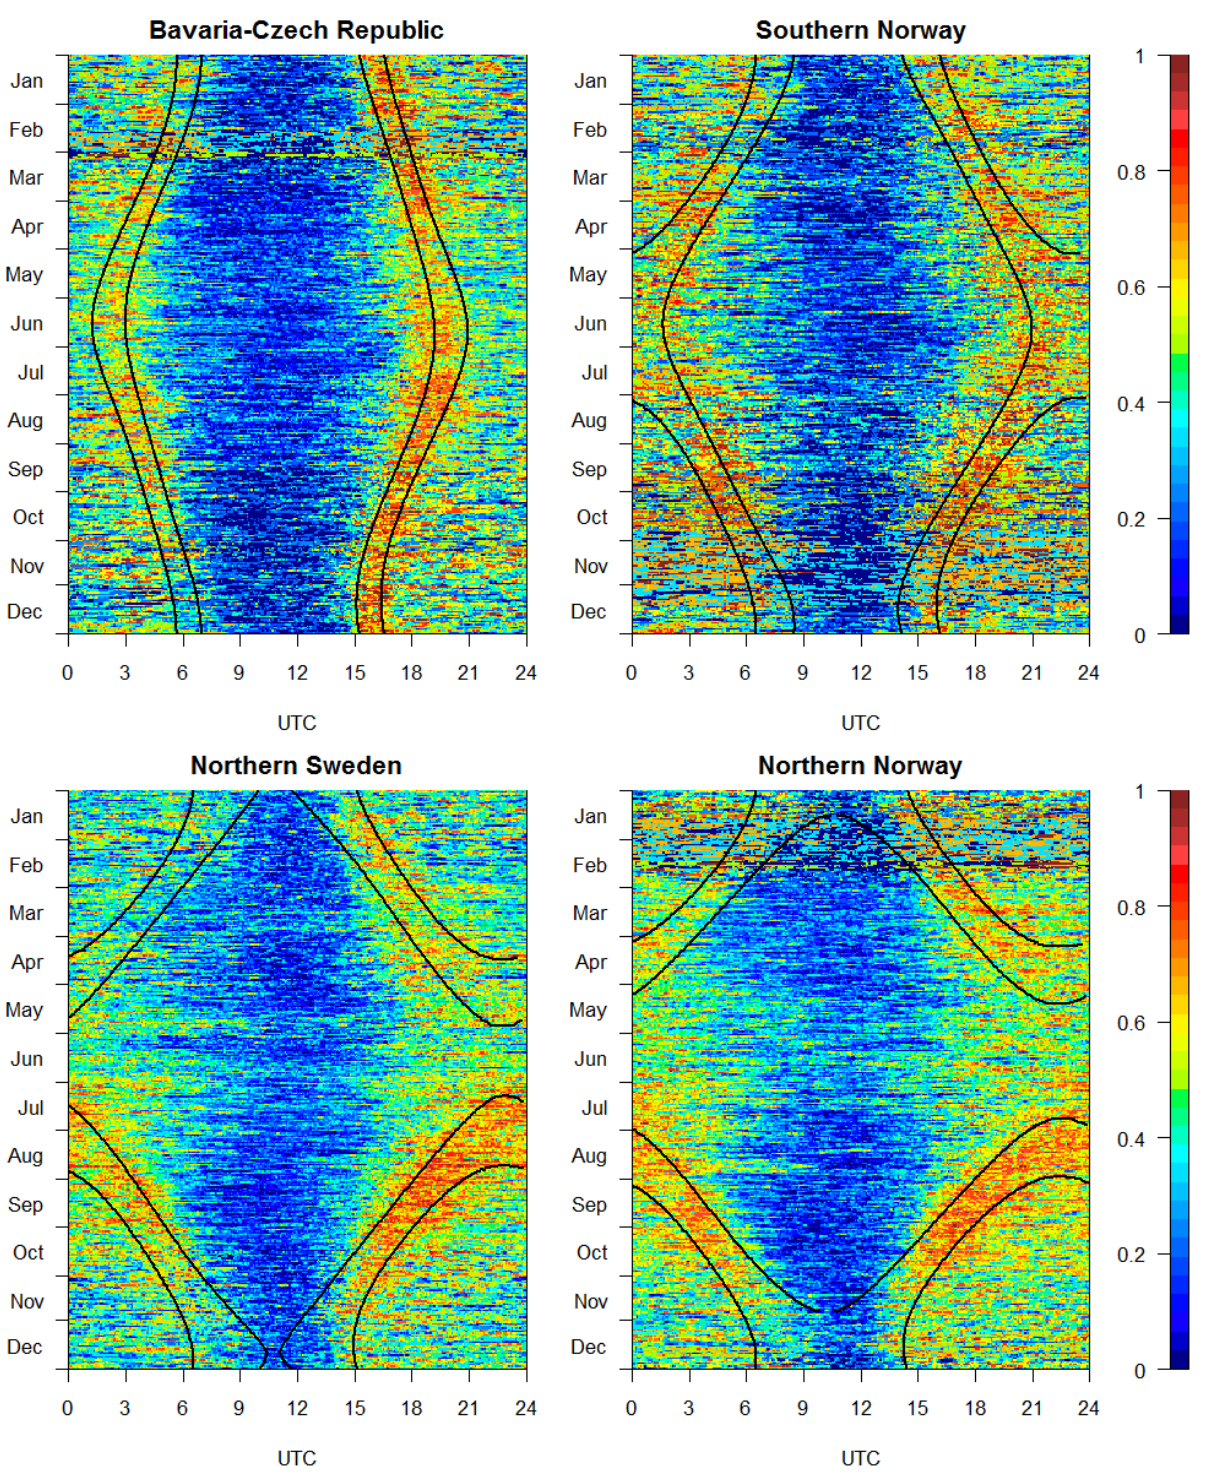
Fig. 2. Actograms of Eurasian lynx activity at the four study sites. Activity was measured as forwards-backwards acceleration on a relative scale from 0 to 255. The x-axes indicate the hours of the day (from 0 to 24 UTC; coordinated universal time). The y-axes indicate the days of the year, with each horizontal line representing one day, from January 1 (top line) to December 31 (bottom line). Each coloured pixel corresponds to one mean activity value at